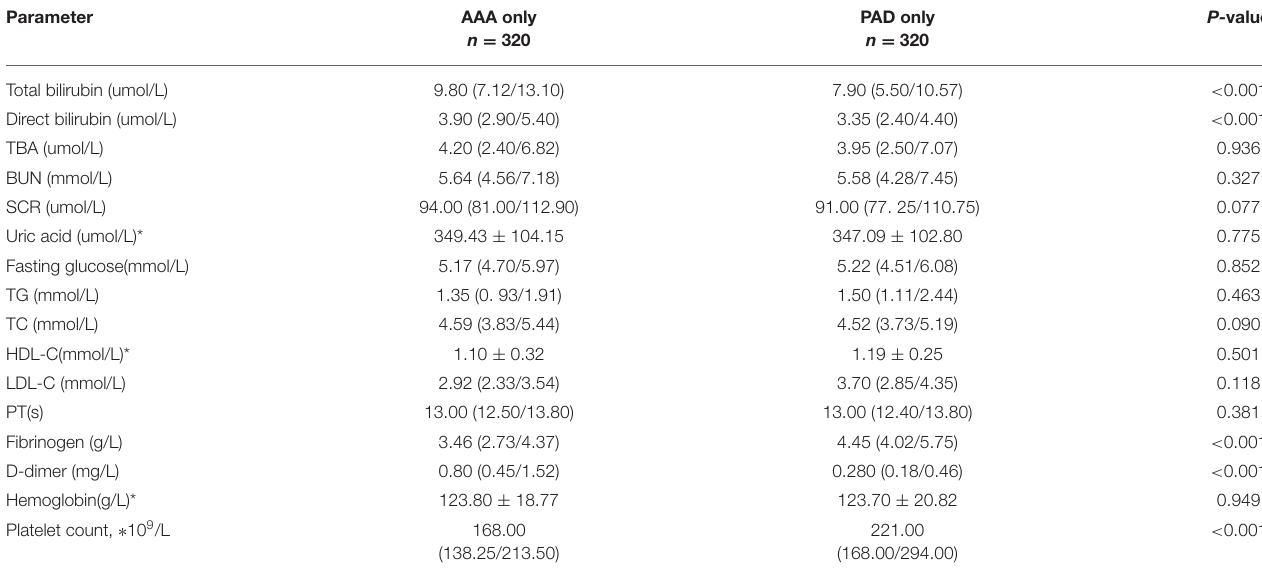
TABLE 2 | Blood Laboratory test profiles of patients in AAA only and PAD only